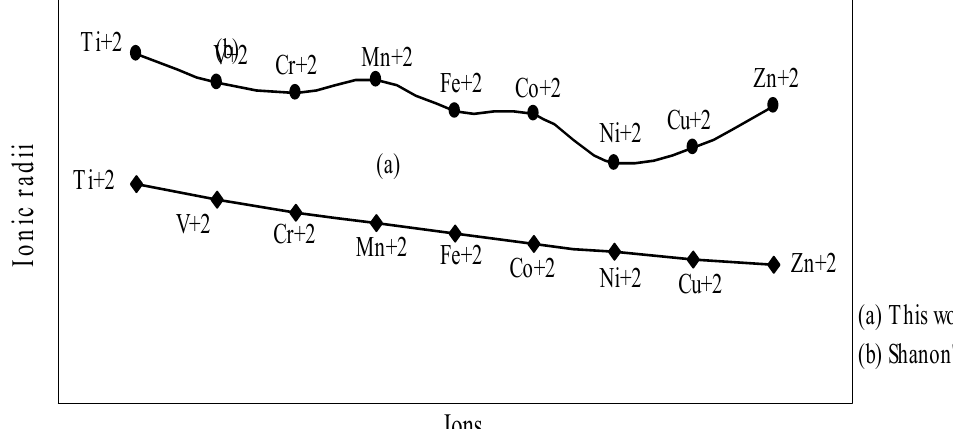
Figure 3. Plot of radii of dipositive ions of first transition series (3d- block) elements